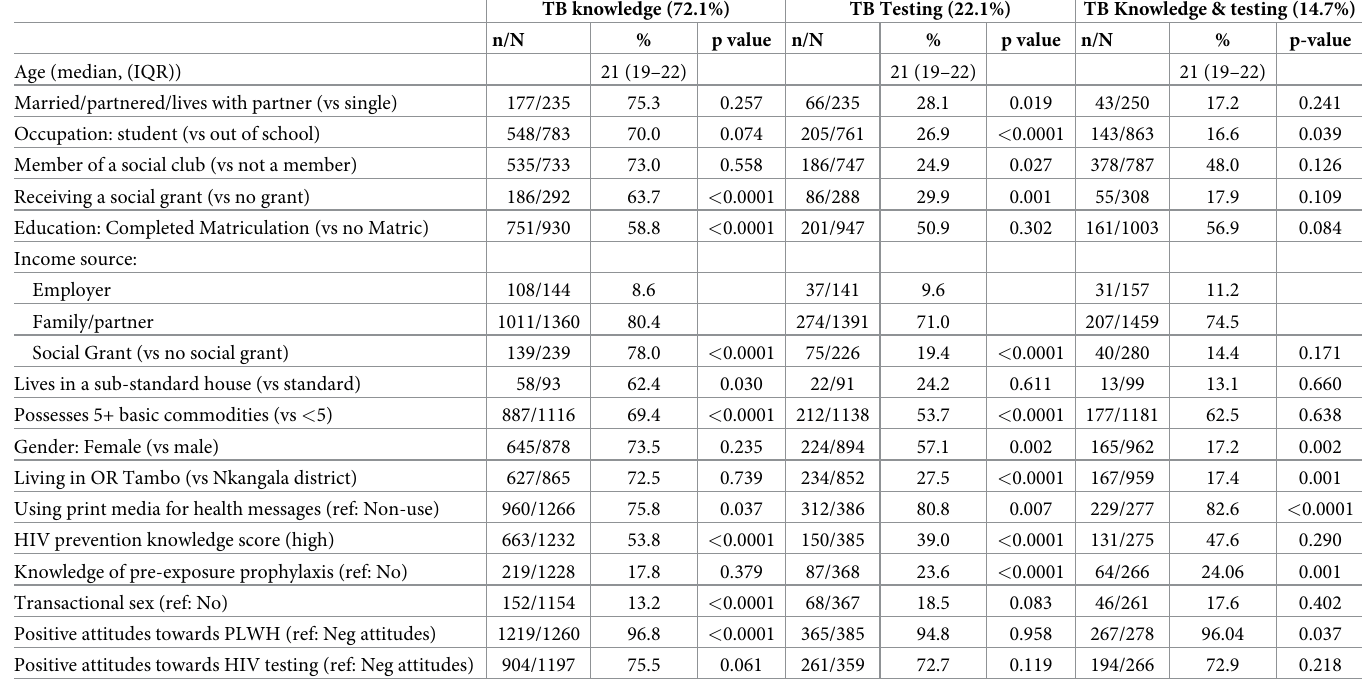
Table 2. Characteristics of participants by TB knowledge, testing and both knowledge and